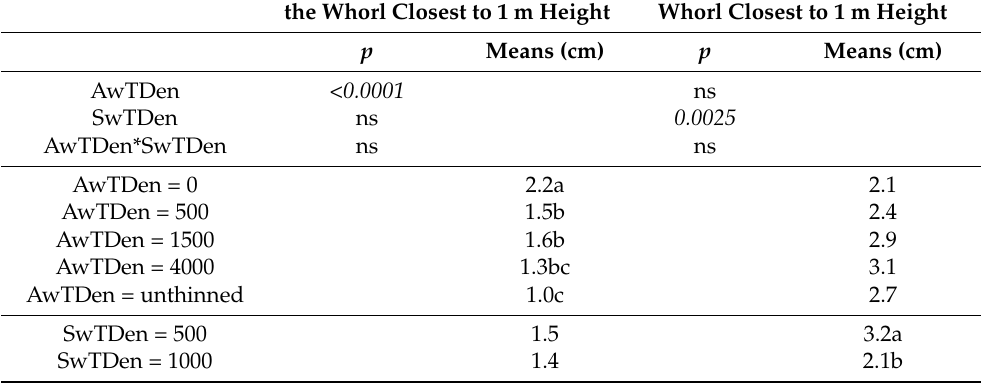
Table 5. Effects of treatments on the number and size of branches in the branch whorl closest to 1 m height. Analysis of treatment effects was based on a factorial design with three levels for aspen density and two levels for spruce density. For both aspen treatment density (AwTDen) and spruce treatment density (SwTDen), means followed by different letters differed significantly ( α = 0.05) based on Tukey’s HSD test.